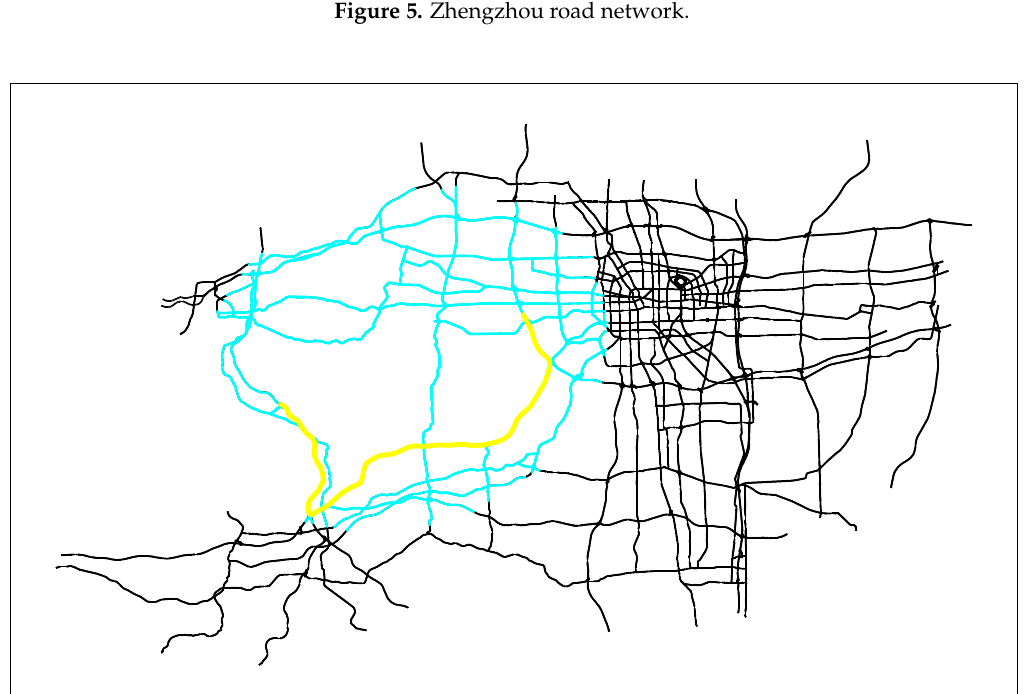
Figure 6. Search results of the shortest path algorithm in the traditional ellipse restricted search area.